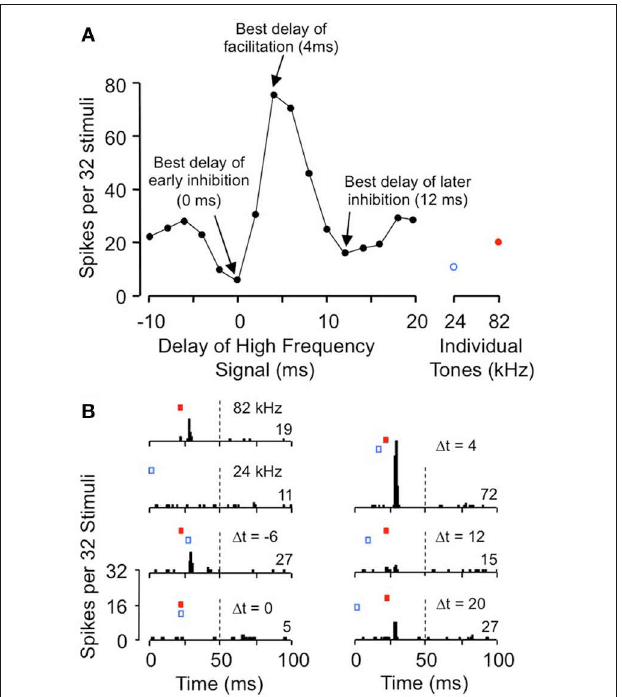
FIGURE 4 | Delay tuning of neuron showing both facilitation and inhibition. (A) This neuron’s excitatory response to ChF tones (at 82kHz) is inhibited by low frequency tones (24kHz) at short and long delays, but is facilitated at intermediate delays. (B) Post-stimulus time histograms showing temporal features of the neuron’s response to tone combinations. Adapted from Nataraj and Wenstrup (2005), with